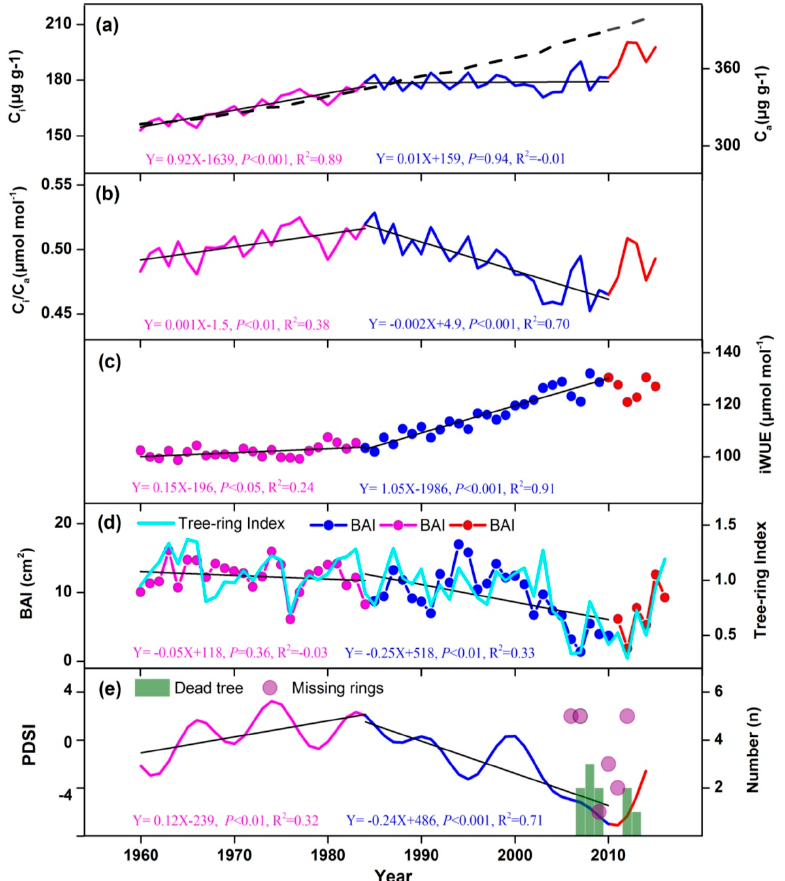
Figure 7. Temporal trends in C a , C i , C i /C a , BAI, and iWUE. Linear regressions are plotted for the periods 1960–1984 (purple), and 1985–2010 (blue), with their respective p and R 2 values. ( a ) The relationship between C i (solid line) and C a (dash line). Temporal trend in C i /C a ( b ), and iWUE ( c ). ( d ) Temporal trend of BAI (line with dotted symbol) and STD chronology (light blue line). ( e ) Temporal trend of scPDSI processed with a ten-year low-pass filter. The number of dead trees (green bars) and missing rings (purple circles) are also shown.